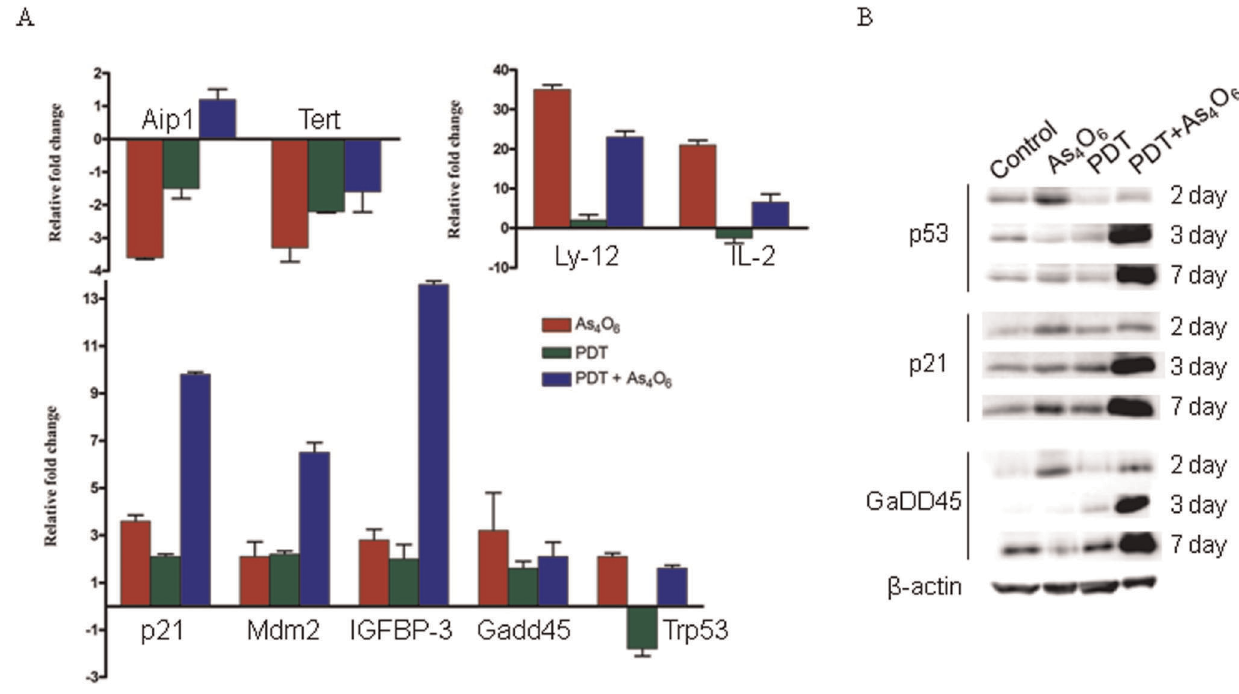
Figure 6. Invivo gene expression profiles in tumor tissues treated with 0.15 ug/ml Radachlorin/PDT or/and 3 uM of As 4 O 6 for 1 day. (A) The expression of genes mRNA in tumor tissues was examined by Q-PCR. The results are presented as transcript levels relative to the level in untreated control cells by using the CT method, with b-actin mRNA levels used as the normalization control. (B) Western blot analysis of in vivo tumor tissues treated with 0.15 ug/ml Radachlorin/PDT or/and 3 uM of As 4 O 6 for several days.